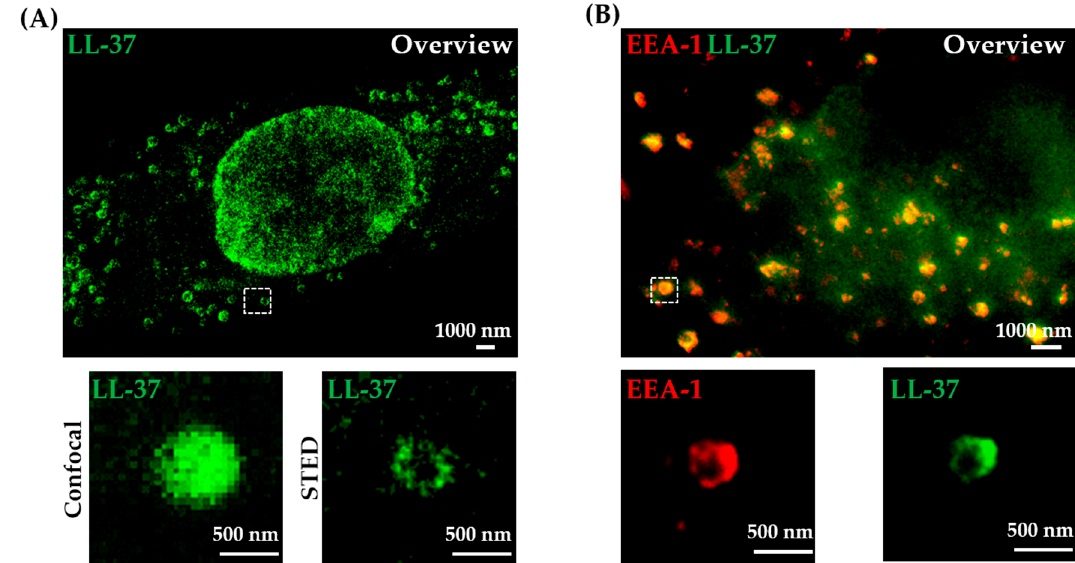
Figure 3. Internalized LL-37-TAMRA localizes with early endosomes in uninfected human macrophages. Cells were incubated with LL-37-TAMRA for 30 min. ( A ) Depicted image shows internalization of LL-37-TAMRA (green) for a representative area of one donor (n = 3). Top image represents an overview of a cell, while bottom images show region of interest for a single vesicle (dashed box magnified approximately five times) with confocal (left) and STED (right) settings. ( B ) Early endosomes were labelled using an anti-EEA1 antibody. Shown is a representative cell of one donor (top, n = 3) with the region of interest for a single vesicle (dashed box magnified approximately five times, bottom). Early endosomes are depicted in red, LL-37-TAMRA in green. Images were first acquired in confocal mode, followed by STED imaging with a pixel dwell time of 300 μ s and a pixel size of 20 nm. Scale bar is 1000 nm for overview images and 500 nm for the shown region of interest.